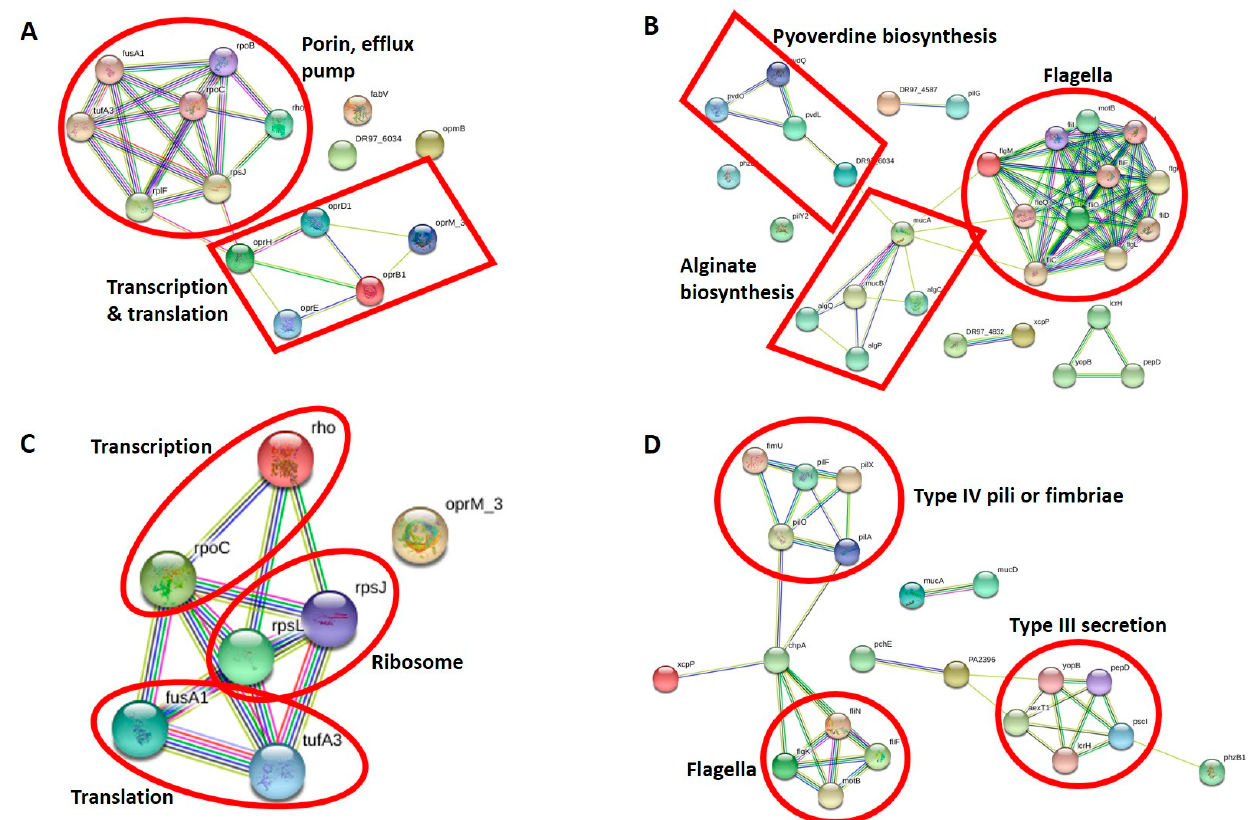
Figure 6. ( A ) Protein–protein interaction network analysis of DEPs associated with antibiotic resistance of planktonic cells grown with the control and antibiotic-impregnated catheters using STRING. The following proteins of P. aeruginosa were matched with input proteins: oprB: oprB1, oprM: oprM_3, oprD: oprD1, tufB: tufA3, fpvA: DR97-6034 and fusA2: fusB. Proteins that STRING could not find in the database: oprB2. ( B ) Protein–protein interaction network analysis of DEPs associated with virulence of planktonic cells grown with control and antibiotic-impregnated catheters using STRING. The following proteins of P. aeruginosa were matched with input proteins: pcrH: lcrH, popD: pepD, fpvA: DR97_6034, phzB2: phzB1, fimV: DR97_4587, xcpT: DR97_4832 and popB: yopB. Proteins STRING could not find in the database: PA1096, PA2412, PA2393, PA3352, pvdP, tagQ1 and tssB1. ( C ) Protein–protein interaction network analysis of DEPs associated with antibiotic resistance of biofilm cells grown with control and antibiotic-impregnated catheters using STRING. The following proteins of P. aeruginosa were matched with input proteins: tufB: tufA3 and oprM: oprM_3. ( D ) Protein–protein interaction network analysis of DEPs associated with the virulence of biofilm cells grown with control and antibiotic-impregnated catheters using STRING. The following proteins of P. aeruginosa were matched with input proteins: exoT: aexT1, pvdF: PA2396, pcrH: lcrH, popD: pepD and popB: yopB. Proteins that STRING could not find in the database: PA2393, PA3352 and